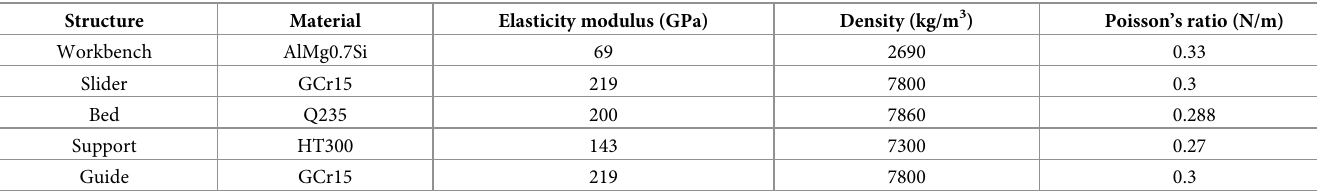
Table 1. Material properties of each part of